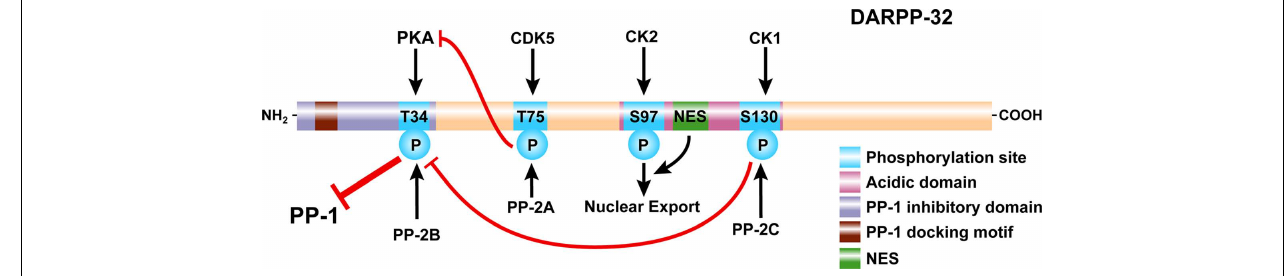
converts DARPP-32 into an inhibitor of PKA, reducing its ability to phosphorylate DARPP-32 and other substrates. Phosphorylation of Ser130 increases phosphorylation ofThr34 through inhibition of PP2B and potentiates dopaminergic signaling via the cAMP/PKA/DARPP-32/PP-1 pathway. In contrast, phosphorylation ofThr75 acts to inhibit dopaminergic signaling via this pathway. Phosphorylation of Ser97 in conjunction with a nuclear export signal (NES) act to export DARPP-32 from the nucleus and maintain the cytoplasmic localization of the protein observed under basal conditions.